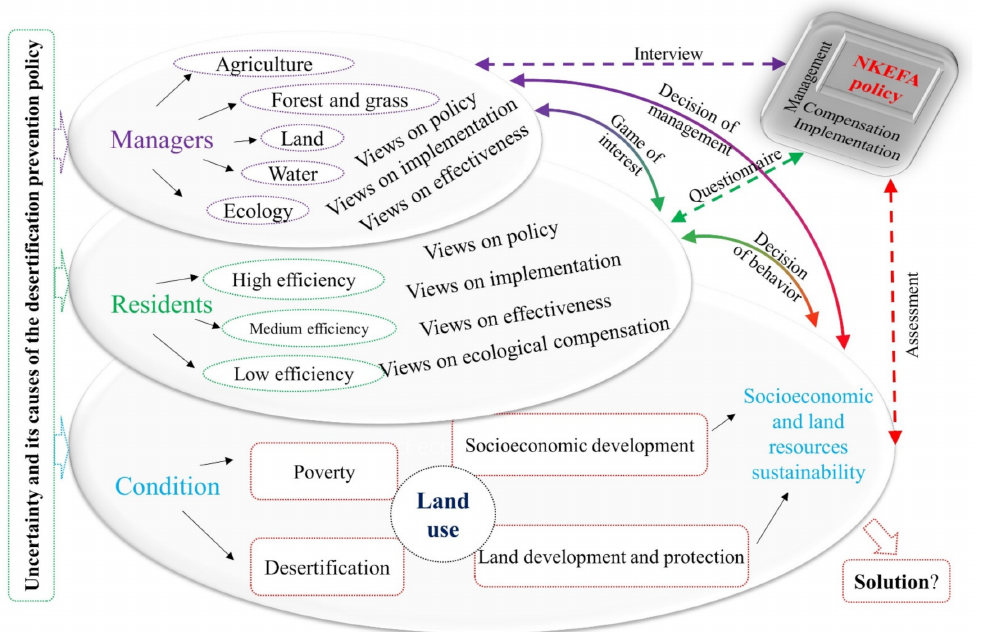
Figure 2. Research framework of NKEFA policy effects. Combining the objective evaluation results and the views of managers and residents, understanding the content that needs attention, and improvement in the process of policy formulation and